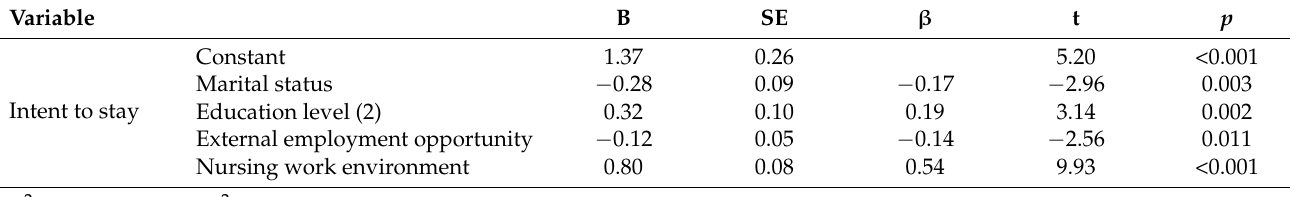
Table 3. Stepwise Multiple Regression Analysis on the Intent to Stay or